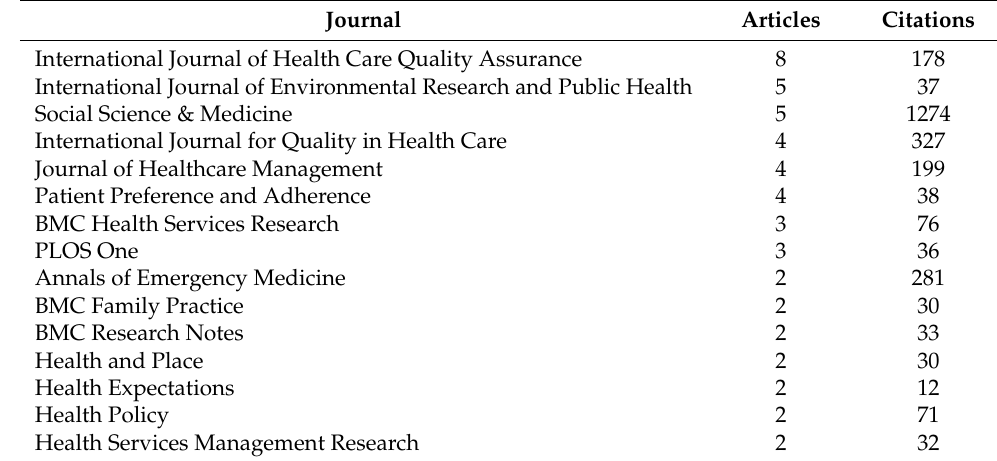
Table 4. Ten of the most utilized journals. The citations presented in this table are the sum of the total citations of the articles published by each journal.